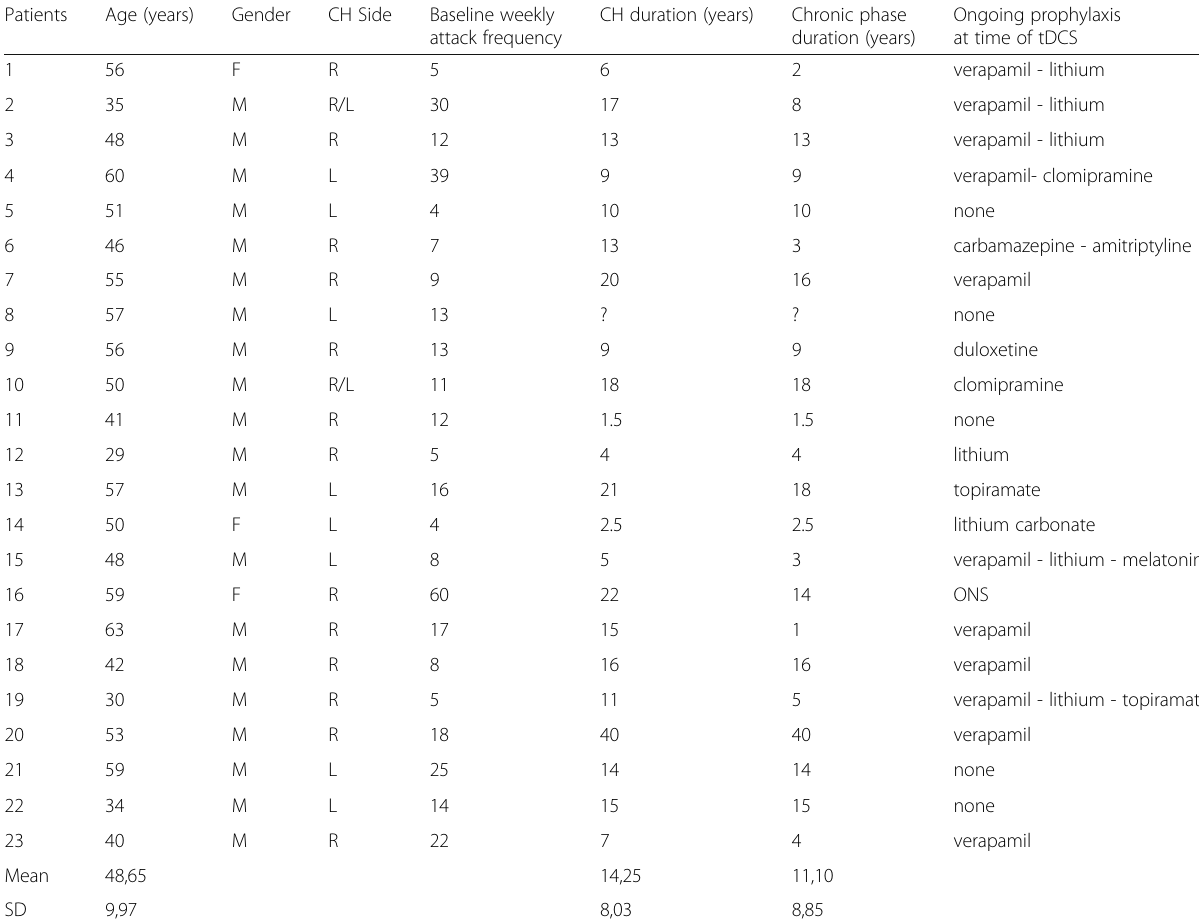
Table 1 Clinical characteristics of patients included in the analysis Patients